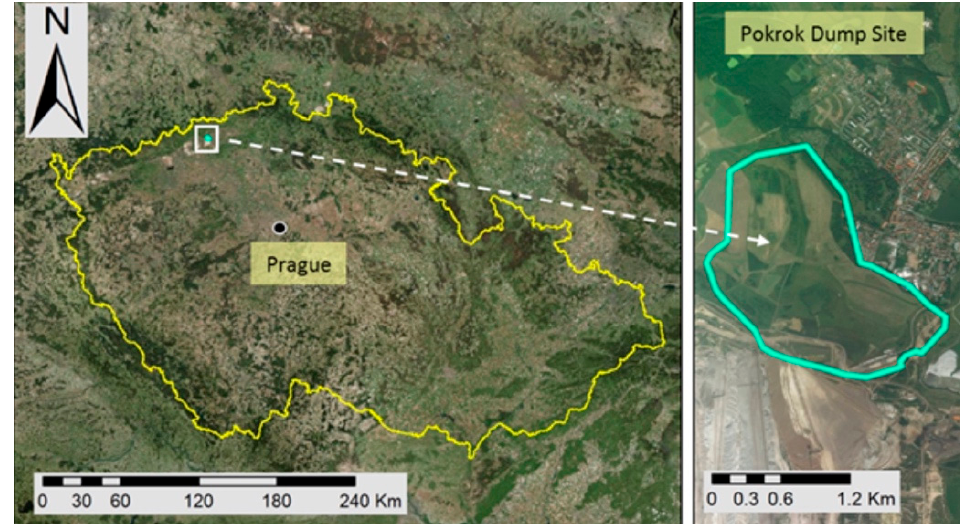
Figure 1. Location of Pokrok dumpsite in the northeastern part of the Czech Republic.